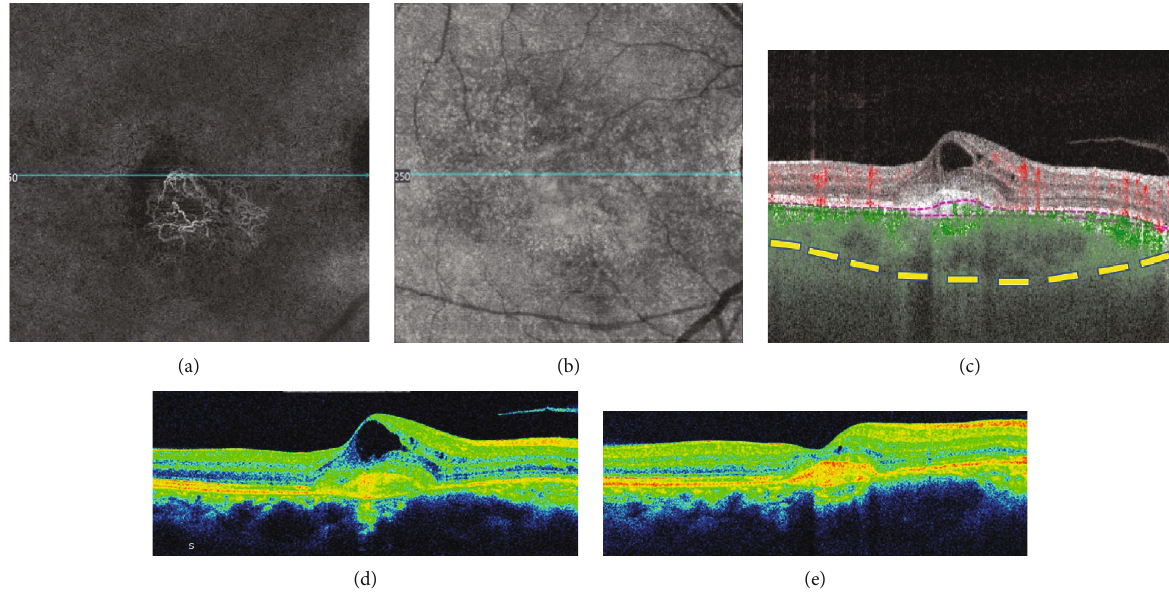
Figure 15: Chronic central serous chorioretinopathy of the right eye with secondary choroidal neovascularization (CNV). A 59-year old male with a history of inhaled triamcinolone use for asthma presented with worsening vision. Using swept source optical coherence tomography angiography (SS-OCTA – PLEX Elite 9000, Carl Zeiss Meditec, Dublin, CA), 6 × 6 scans were analyzed; shown is the slab between the retinal pigment epithelium (RPE) and Bruch ’ s membrane. (a) En face angiography showed the presence of type 1 choroidal neovascularization. (b) En face structural imaging showed RPE elevation causing shadowing. (c) B-scan demonstrated cystoid macular edema, with increased fl ow (green) indicating increased choroidal fl ow in the presence of CNV. The sclerochoroidal junction (yellow dashes) was highlighted to demonstrate the thick choroid. (d, e) OCT prior to and after anti-vascular endothelial growth factor injections showed improvement of intraretinal fl uid and hyperre fl ective